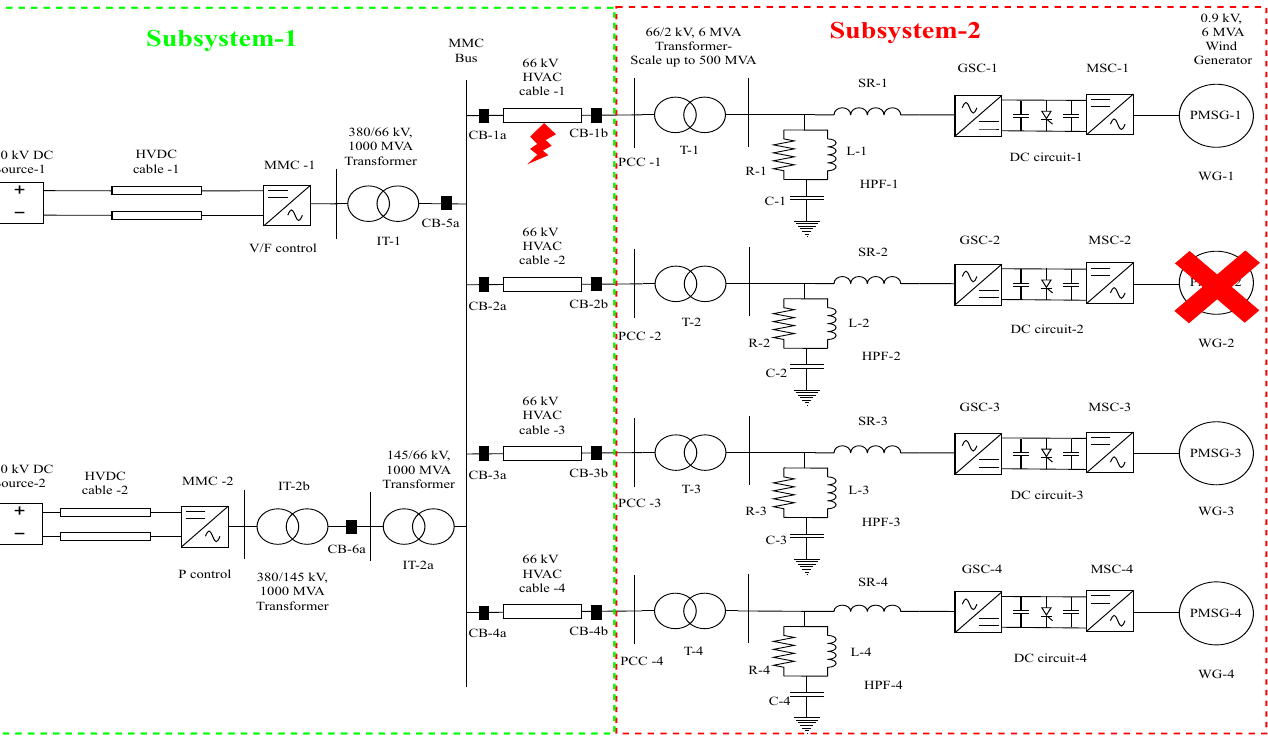
Figure 12. 66 kV HVAC offshore network connected to 2 × 1 GW HVDC links with offshore converter stations in RSCAD for two dynamic scenarios: Disconnection of OWF-2 (represented by the cross symbol); Three-phase line to ground fault in the middle of cable-1 (represented by the fault